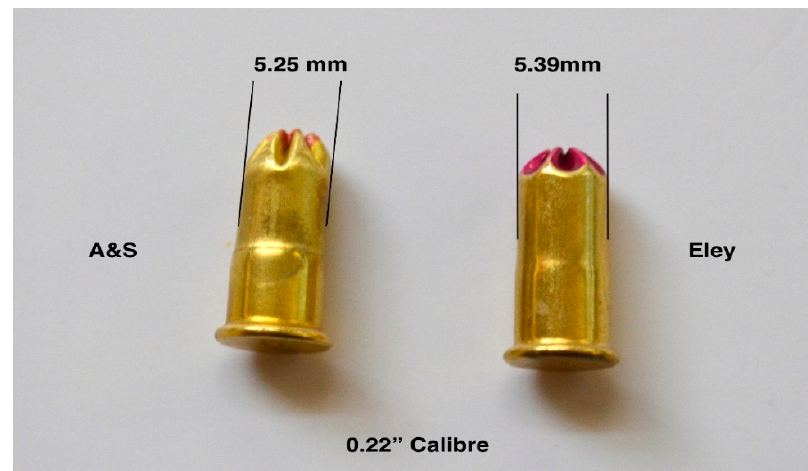
Figure 20. Variation in case diameter between AS and Eley cartridges for use in the same 0.22 ″ calibre device.